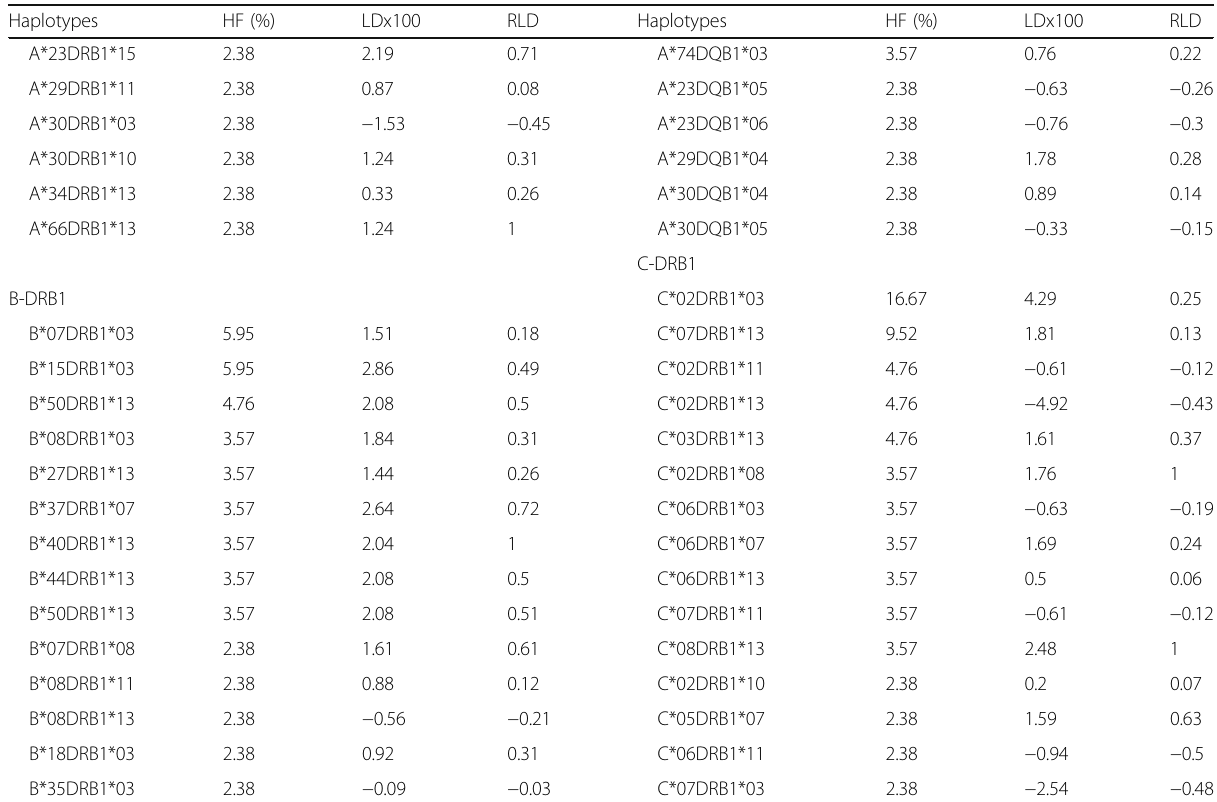
Table 4 Most encountered HLA (class I-class II) two loci haplotypes (Continued)